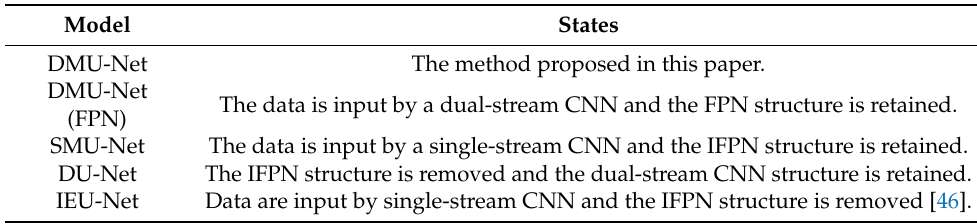
Table 4. Models of different network structures.